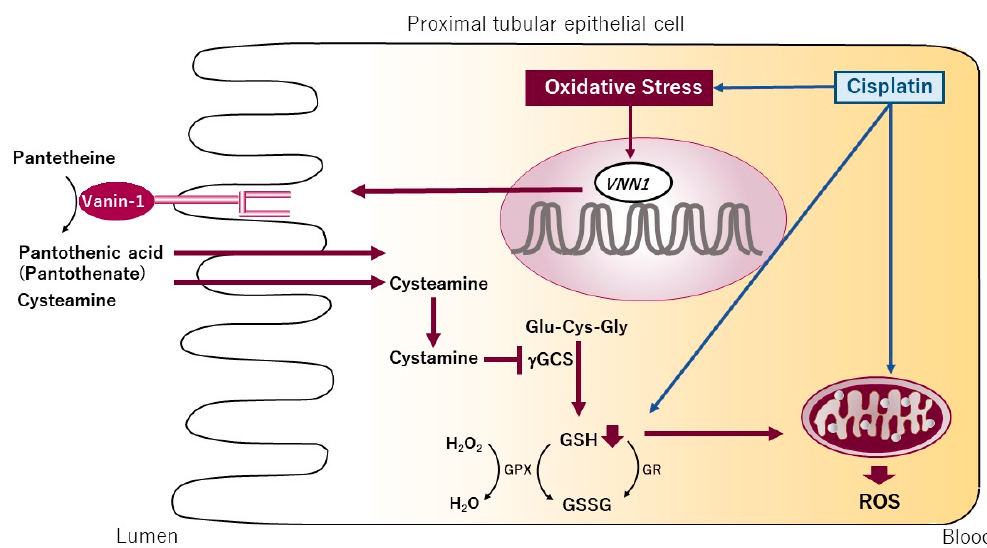
Figure 1. Schematic diagram of the postulated vanin-1 pathway in renal tubular epithelial cells in response to oxidative stress. This overview is based on the works of Dupre et al. [75] and Pitari et al. [72]. An inciting drug (e.g., cisplatin) induces generation of free radical species. Although reactive oxidative stress (ROS) has a positive modulatory role, excessive ROS or inadequate capability of antioxidant scavengers leads to oxidative stress. In the presence of oxidative stress, antioxidant response-like elements within the promoter region of VNN 1 act as stress-regulated targets and enhance VNN 1 expression. More cysteamine is produced from hydrolysis of pantetheine; cysteamine is then converted to cystamine, which is an inhibitor of γ -glutamylcytein synthetase ( γ -GCS), the rate-limiting enzyme of glutathione (GSH) synthesis. Consequently, GSH stores decrease and subsequently intensifies the oxidative stress, producing more inflammatory cytokines and chemokines. GPX: glutathione peroxidase; GR: glutathione reductase; GSSG: glutathione disulfide.